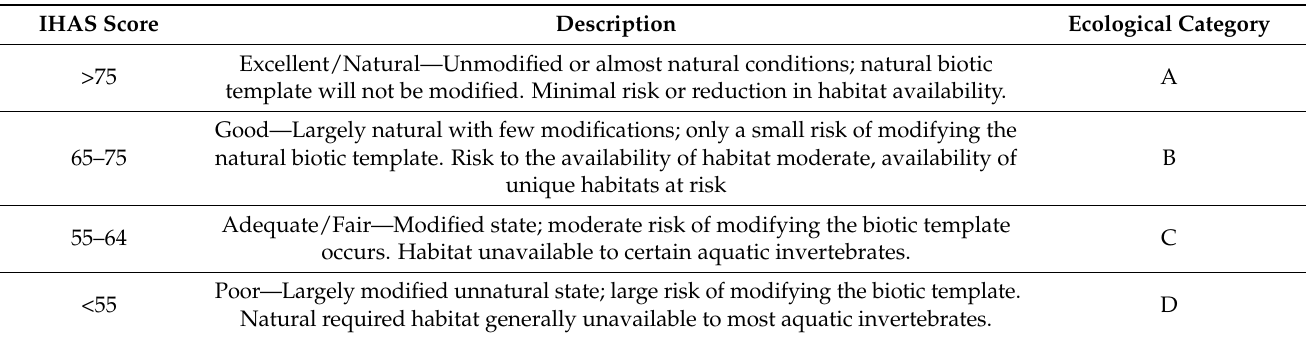
Table 1. Invertebrates habitat assessment system scoring guidelines